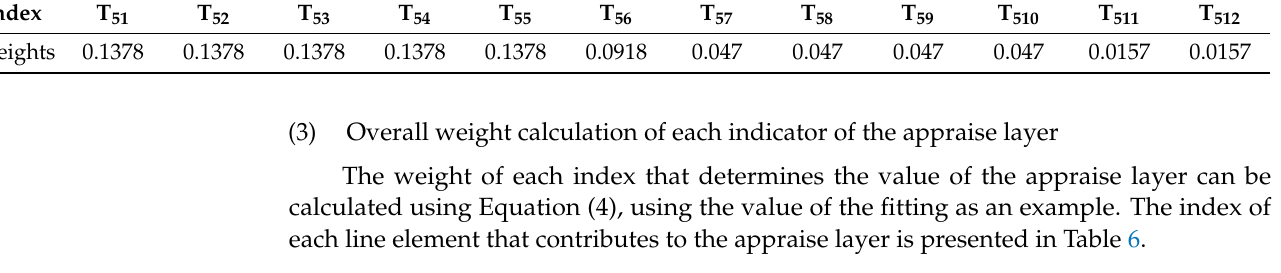
Table 6. Overall weights of various indicators of the hardware appraise